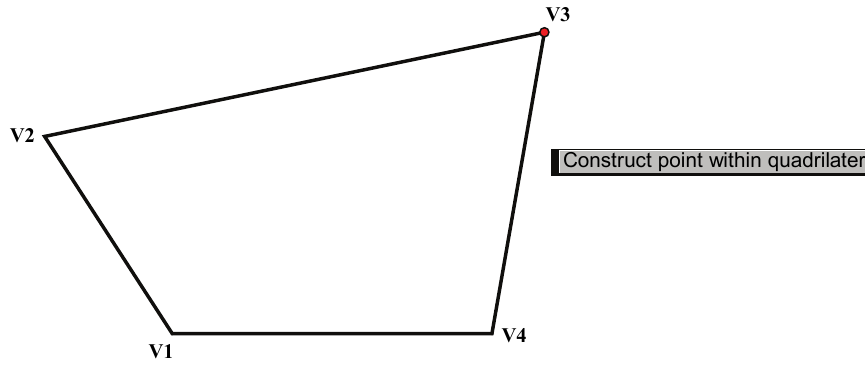
Figure 7 : Learners trying to find the centre of the